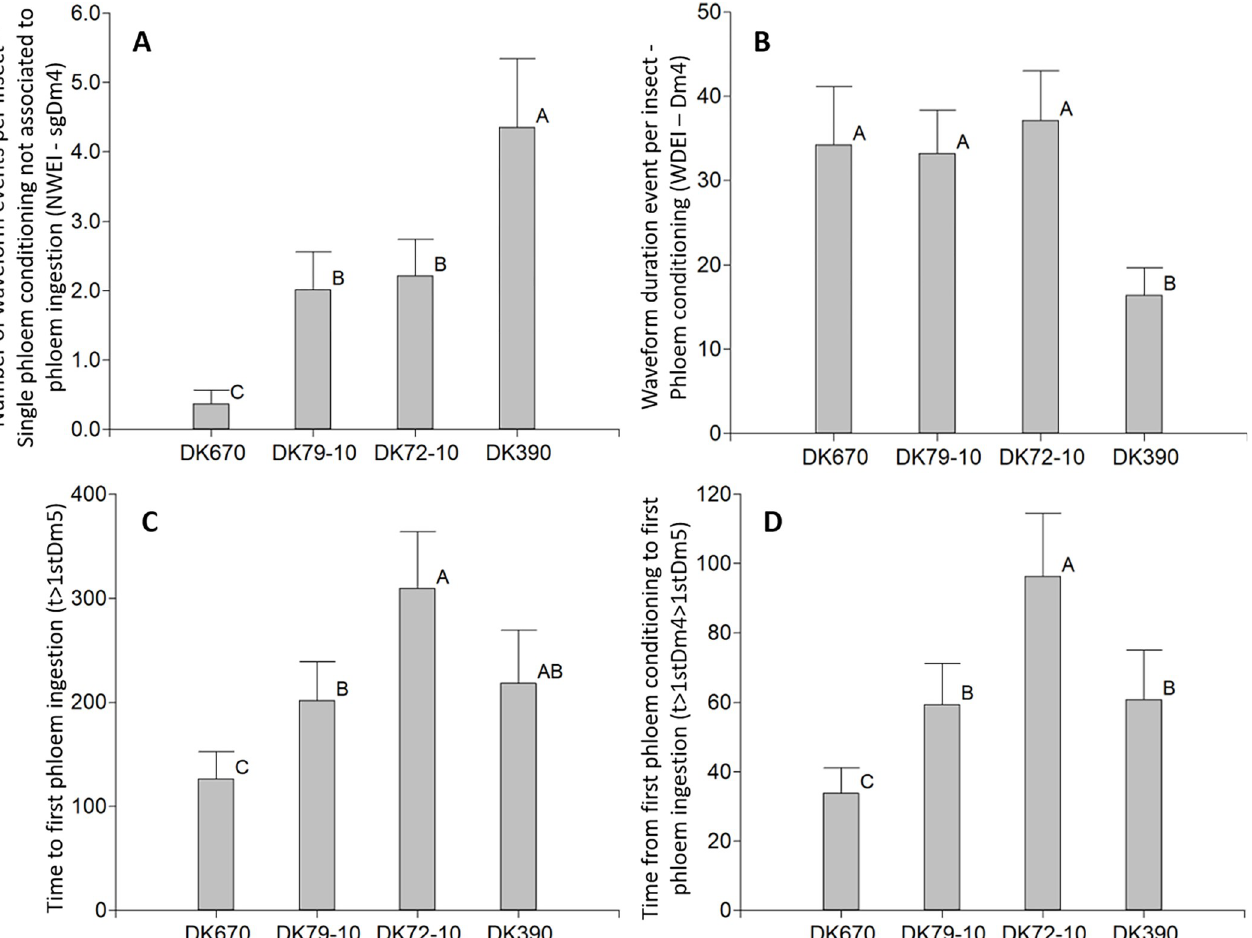
Fig 4. Variables of probing behavior of D . maidis insects with access to four maize hybrids, phloem phase. A: Number of waveform evens per insect— Single phloem conditioning not associated to phloem ingestion (NWEI—sgDm4), B: Waveform duration event per insect—Phloem conditioning (WDEI— Dm4), C: Time to first phloem ingestion (t > 1stDm5), D: Time from first phloem conditioning to first phloem ingestion (t > 1stDm4 > 1stDm5). Values with the same letter are not significantly different according to contrasts in the Fisher LSD test ( α = 0.05). Bars indicate standard error of the mean.